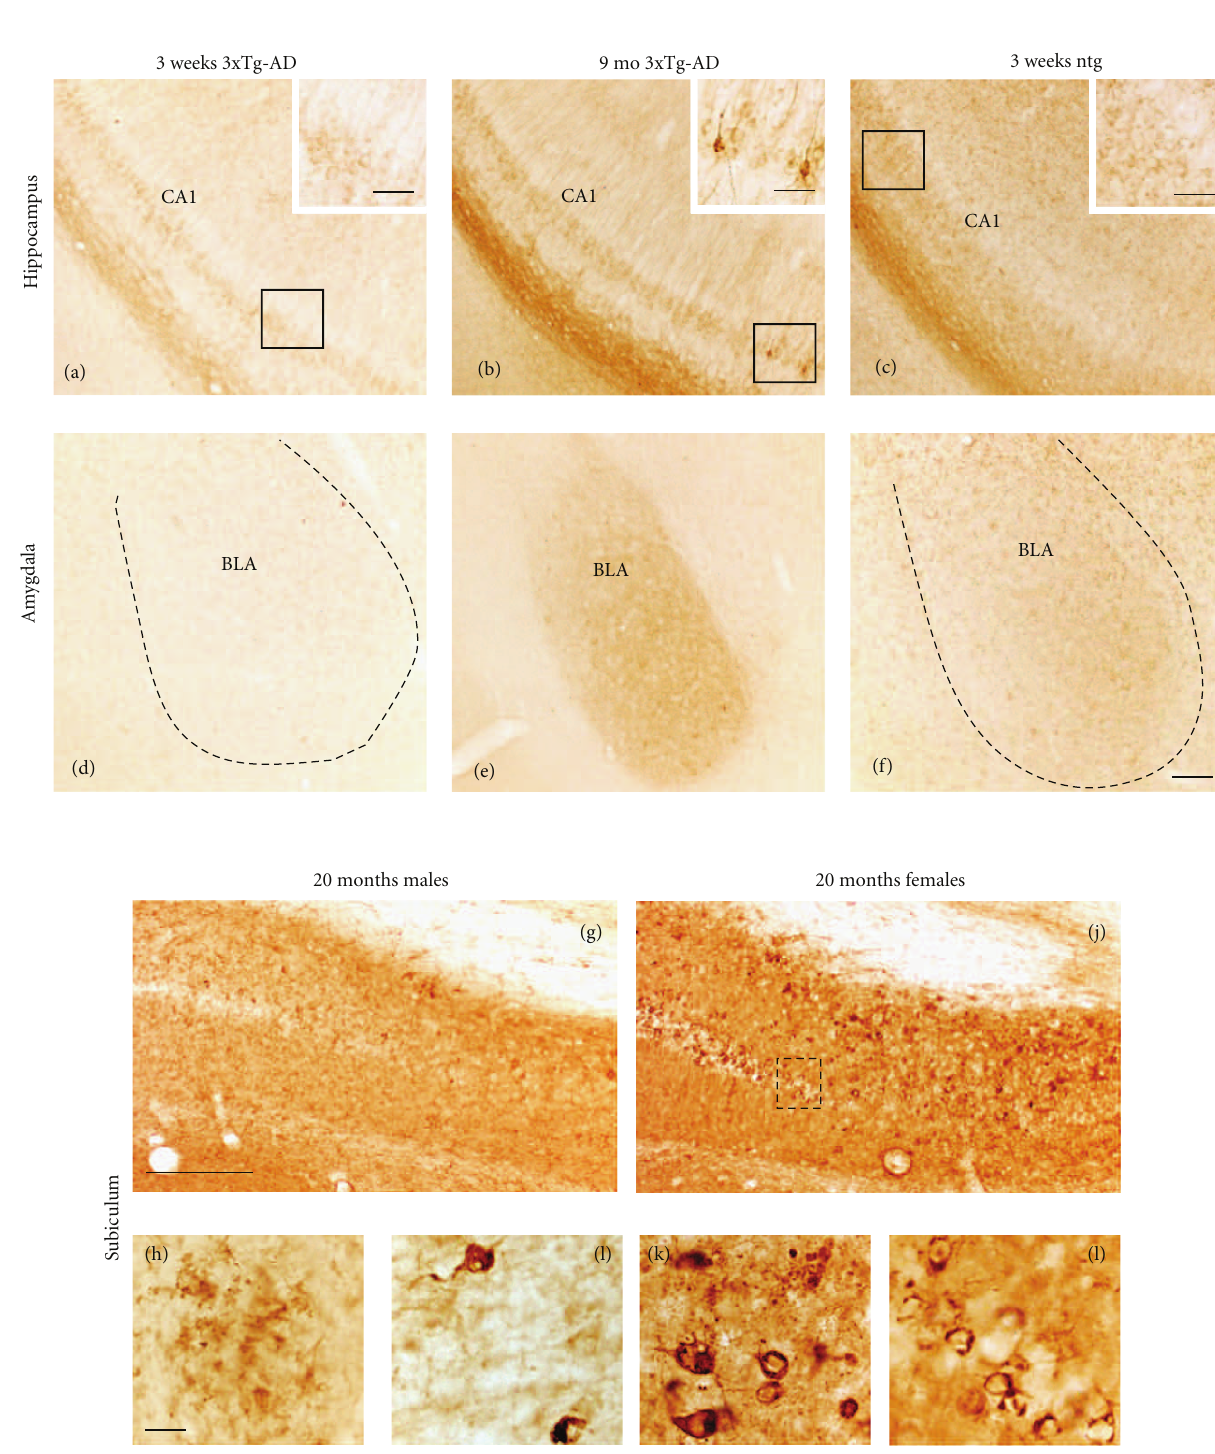
Figure 6: Photomicrographs showing MC1 immunoreactivity within the hippocampal CA1 field ((a)–(c)), BLA ((d)–(f)) and subiculum ((g)–(l)) at 3-week, 2–4-, 8-9-, and 20-month-old 3xTg-AD mice. Dashed line in (d) and (f) outlines the area containing the BLA. Note the increase in MC1 neuronal immunostaining in hippocampal CA1 neurons ((b), higher magnification shown in insert), the neuropil in the BLA (e) at 2–4 month and the reduction in reactivity in these areas in 9-month-old mutant mice ((c), higher magnification shown in insert and (f)). Low-magnification images of the subiculum from male (g) and female (j) 20 months of old 3xTg-AD mice. Example of MC1-ir neurites was observed in the subiculum of a male mutant mouse ((h)). Both male ((i)) and female ((j), higher magnification of boxed area shown in (l)) mutant mice displayed dystrophic subicular MC1-ir neurons. Scale bars: ((a)–(f)); ((g), (J)) = 100 μ m, insets = 35 μ m, ((h), (i), (k), (l)) = 20 μ